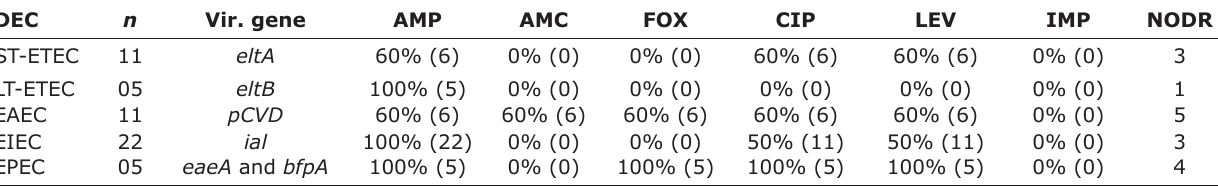
Table-2: Relationship between diarrheagenic Escherichia coli virulent pathotypes and antimicrobial